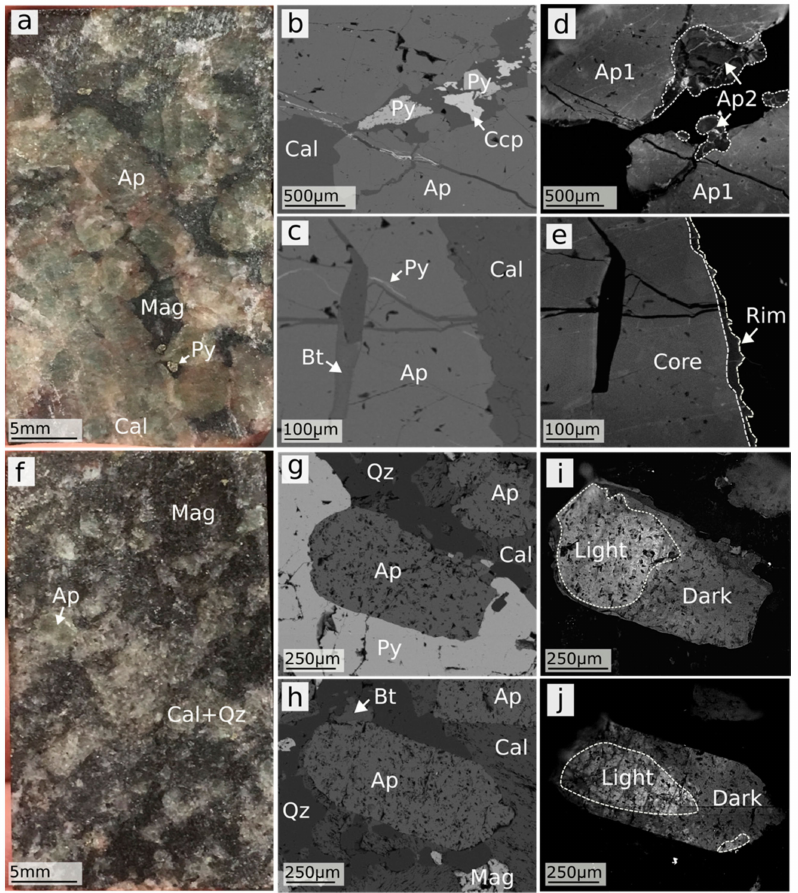
Figure 8. ( a ) Sample BC10 displaying coarse-grained apatite with fine-grained calcite, quartz, magnetite, and pyrite; ( b ) BS image of a coarse-grained apatite from the BC10 sample brecciated by a later assemblage of calcite, pyrite, and chalcopyrite with fine-grained Ap2 apatite; ( c ) BS image of a coarse-grained apatite rim from sample BC10 showing inclusions of biotite, pyrite, and calcite. CL images of ( d ) Figure 8b and; ( e ) Figure 8c. CL images highlight the difference in the homogeneous, light, coarse-grained apatite and the dark rims/Ap2 apatite; ( f ) Sample BC22 consisting of medium-grained apatite in a matrix of quartz, calcite, magnetite and biotite with minor sulphides; ( g ) BS image of apatite from the BC22 sample enveloped by the later growth of pyrite, with surrounding quartz and calcite; ( h ) BS image of apatite from sample BC22 surrounded by paragenetically later calcite, quartz, biotite, and magnetite. CL images of ( i ) Figure 8g and ( j ) Figure 8h highlighting the vuggy textures and irregular zonation depicted by dark and light